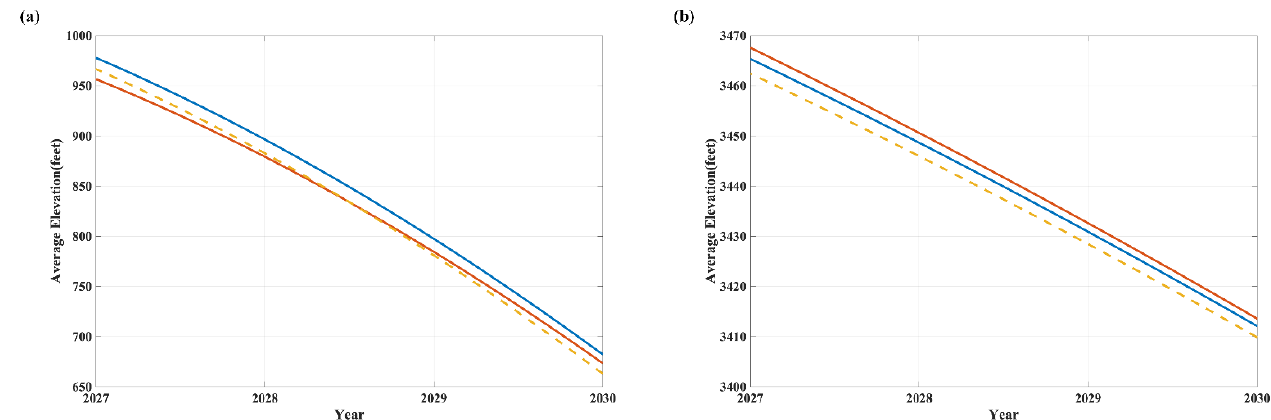
Figure 17. The results of sensitivity analysis of the dam water level prediction model. The blue line in the figure is the standard fit curve. The red line shows the curve obtained by slightly increasing the parameters. The yellow line shows the curve obtained after the parameters are slightly reduced. ( a ) The HD. ( b ) The GCD.